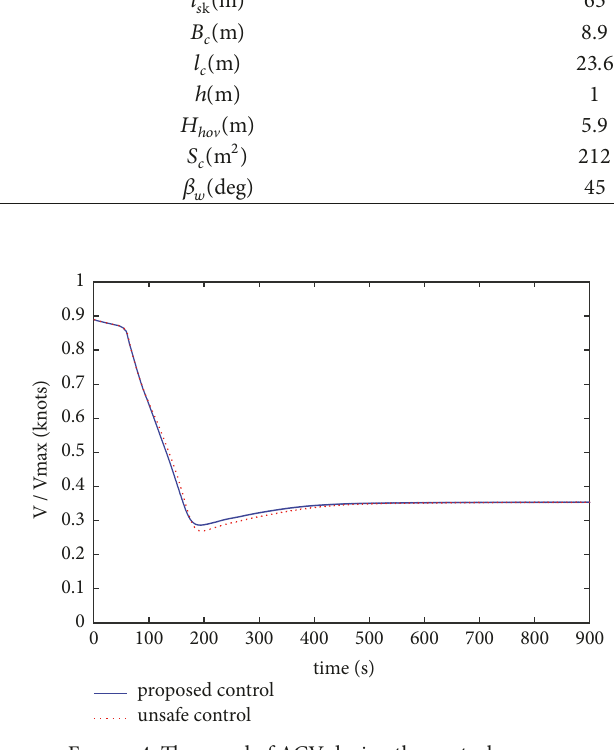
Figure 4: The speed of ACV during the control